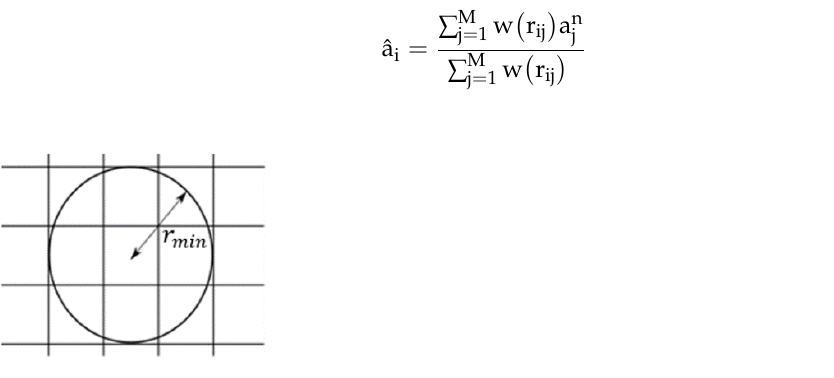
Figure 3. FE-Element with neighboring elements. If the adjacent elements lie within the radius r min , the sensitivities are averaged according to formula (5) and (6).